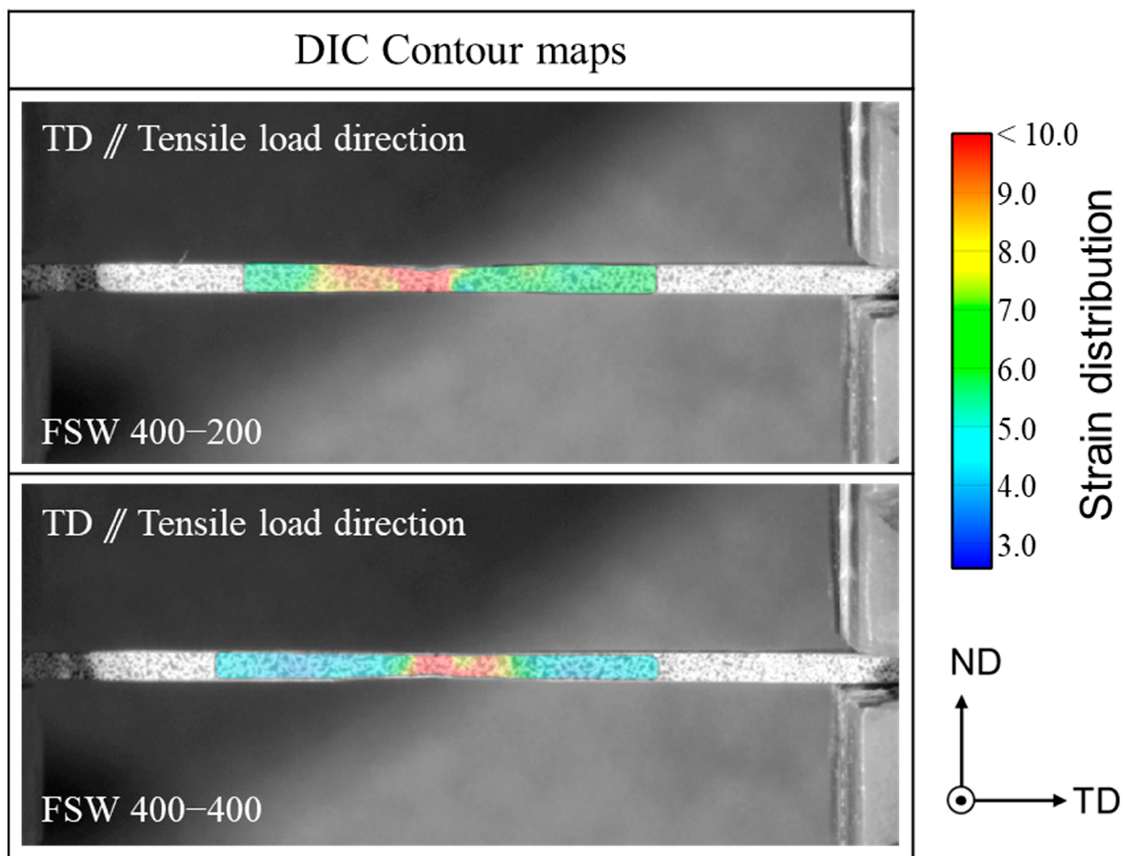
Figure 5. Cross-sectional contour maps of the strain distribution during the tensile test with the DIC technique concerning to strain levels.